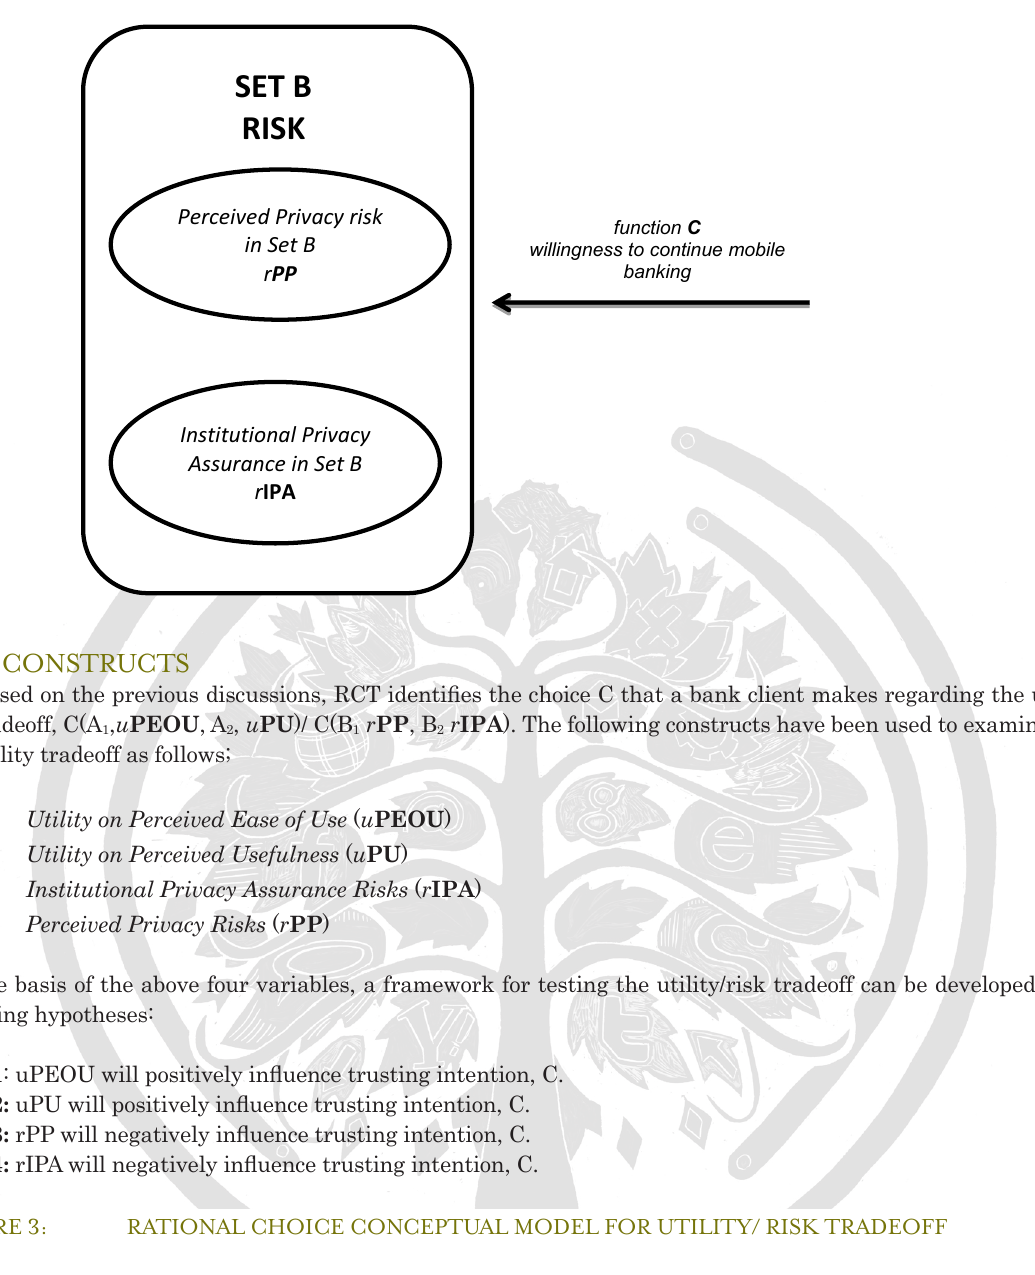
FIGURE 2: RISK SET AND SUB SET